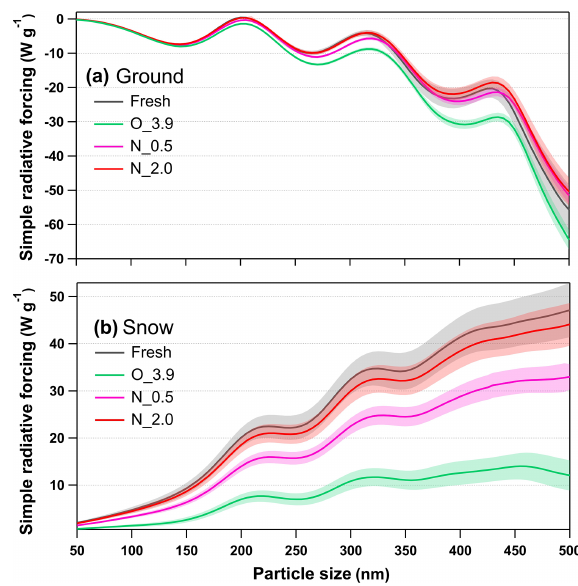
Figure 11. Calculated size-resolved simple radiative forcing (SRF, Wg − 1 ) by tar ball aerosols, integrated over 365–425nm incident solar irradiation for fresh and NO x -dependent photooxidized tar balls: (a) ground-based radiative forcing, (b) snow-based radiative